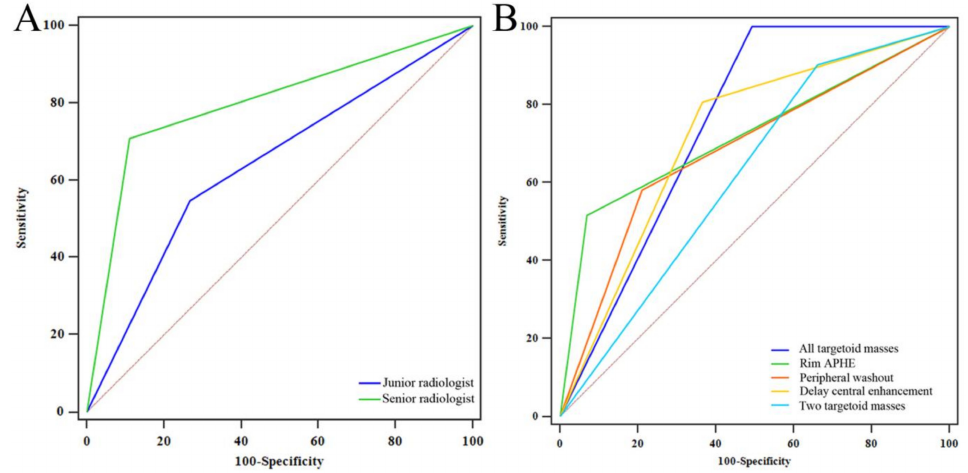
Figure 6. Comparison of the receiver operating characteristic curves of junior and senior radiologists ( A ) and each targetoid mass ( B